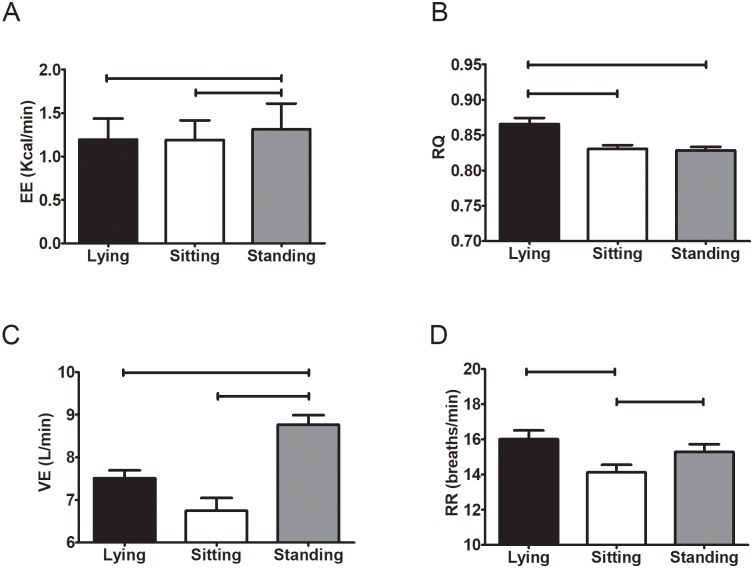
Energy expenditure (EE; panel A), respiratory quotient (RQ; panel B), minute ventilation (VE; panel C), and respiratory rate (RR; panel D) in lying, sitting, and standing positions.Values are expressed as mean ± standard deviation. P value derived of repeated measures analysis of variance followed by the Bonferroni post hoc test. Parallel lines mean P<0.001.